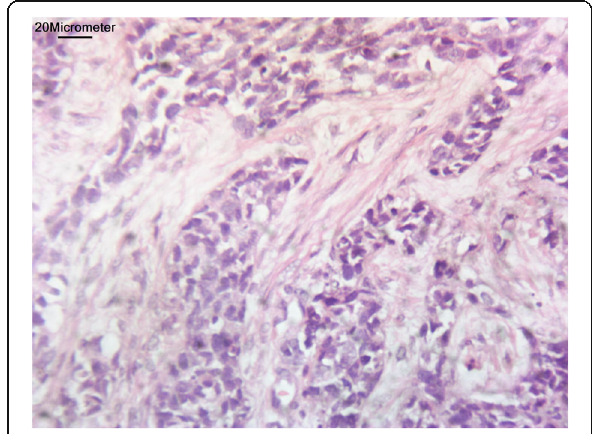
Fig. 1 The tumor cells were small with marked degree of atypia and pleomorphism and high mitotic activity